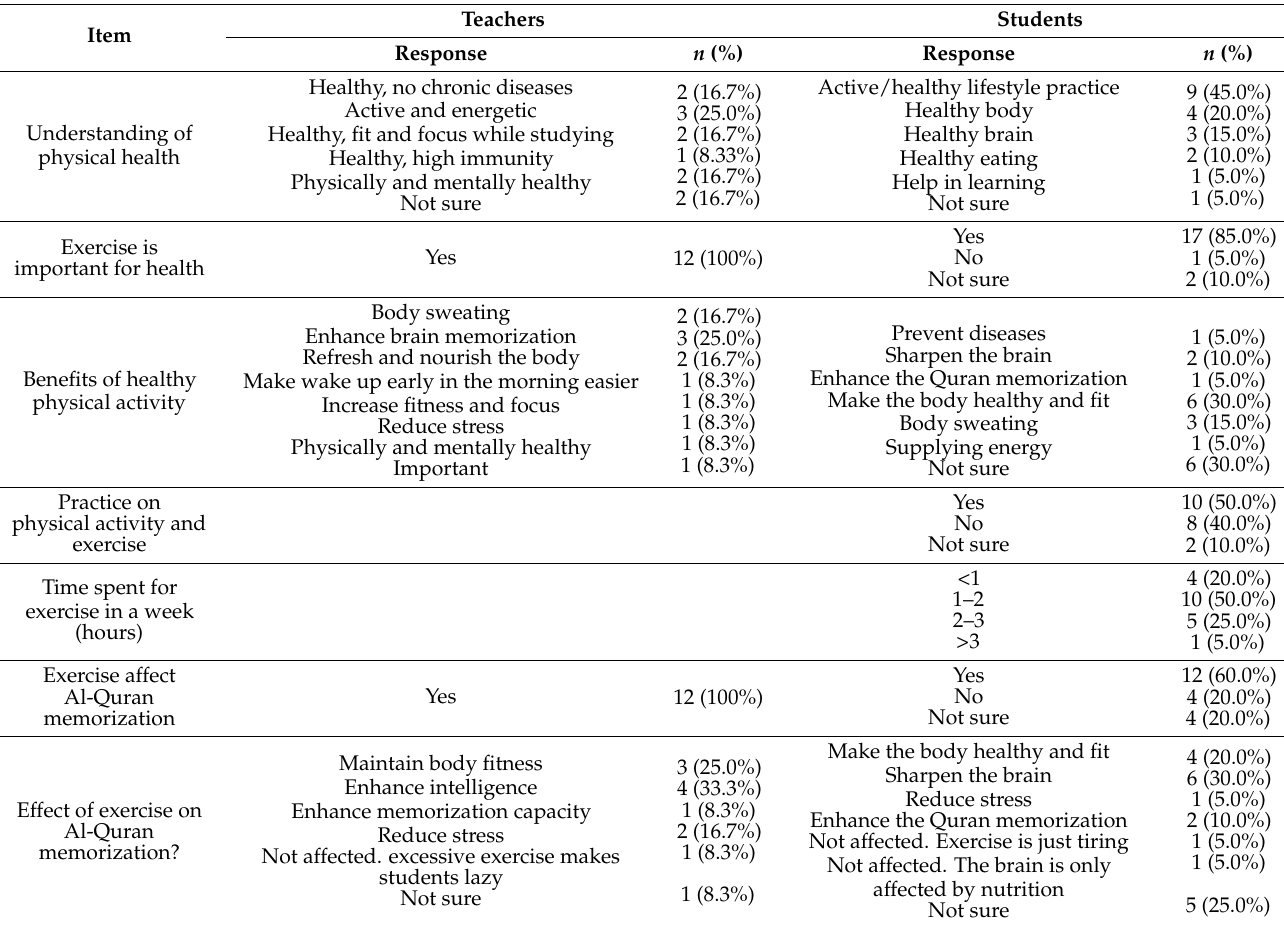
Table 3. Tahfiz school students and teachers’ responses to the physical health, healthy diet, and psychological well-being